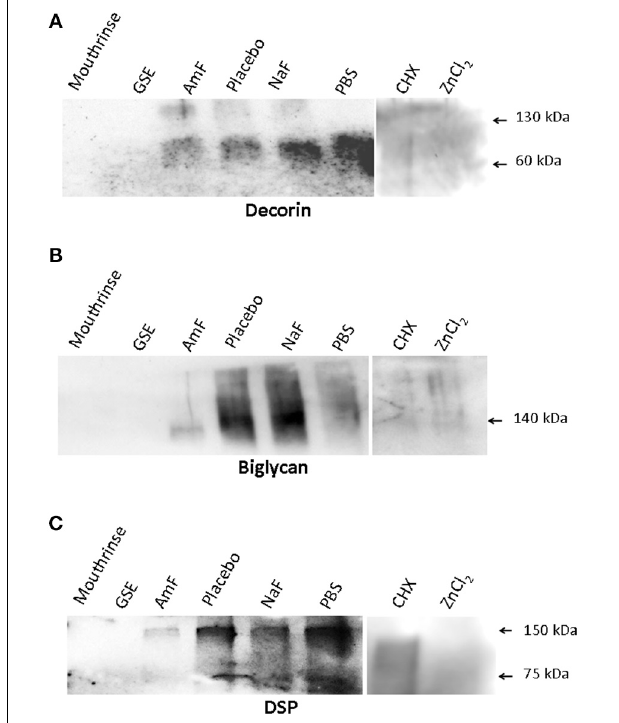
FIGURE 1 | Western blot analysis assessing the ability of the tested Mouthrinse to prevent NCP release. (A) DCN is detected as a main band at 60kDa in the following groups: pre-treatment with amine fluoride (AmF), placebo, NaF, and PBS. An additional fainter band is seen at 130kDa in the AmF and placebo groups. No band is observed in the Mouthrinse, GSE, CHX, and ZnCl 2 pre-treated groups. (B) BGN is detected as a large band around 140kDa in placebo, NaF, and PBS pre-treated groups. This band appears fainter in the AmF group. No band is observed in the Mouthrinse, GSE, CHX, and ZnCl 2 pre-treated groups. (C) Dentin sialoprotein (DSP) is observed at 150 and 75kDa in the AmF, placebo, NaF and PBS pre-treatment groups. A smeary signal is detected in the CHX pre-treated group whereas no band is present in the Mouthrinse, GSE, and ZnCl 2